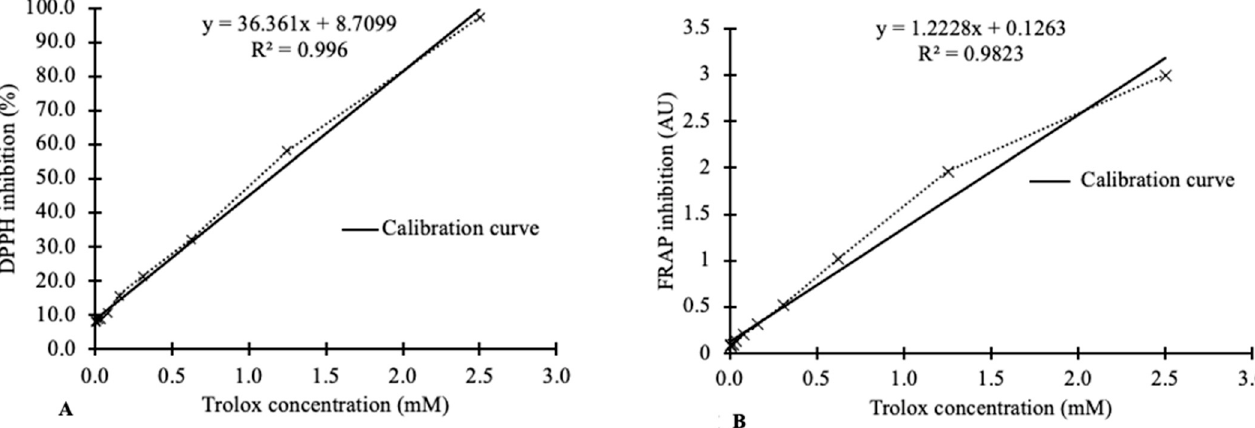
Figure 2. Calibration curves used for ( A ) DPPH (2,2-diphenyl-1-picrylhydrazine) reduction and ( B )